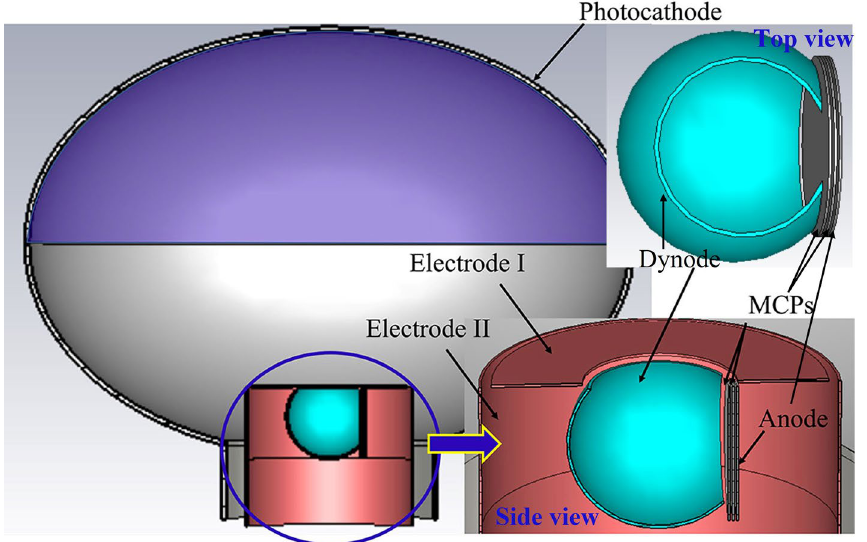
Figure 1. Schematic diagram of the Dynode-MCP-PMT.